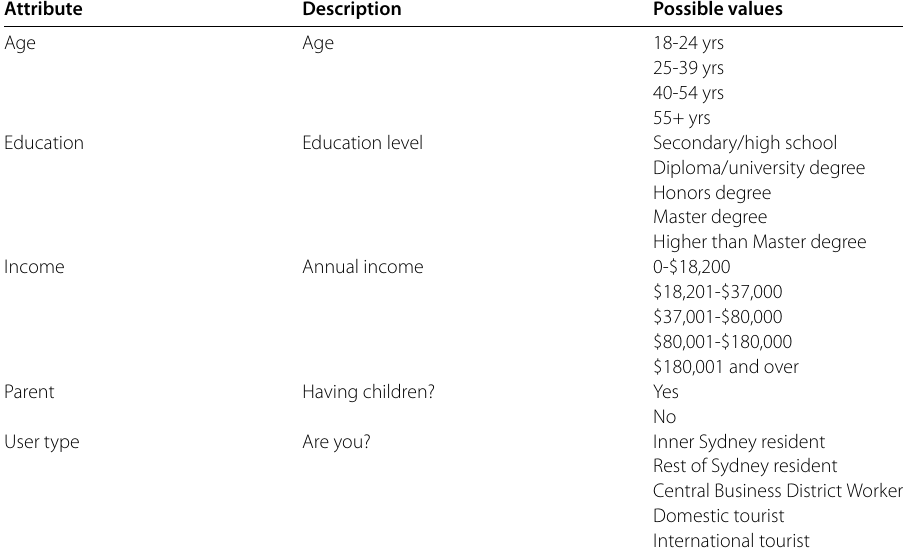
Table 1 Demographic attributes of questionnaire data